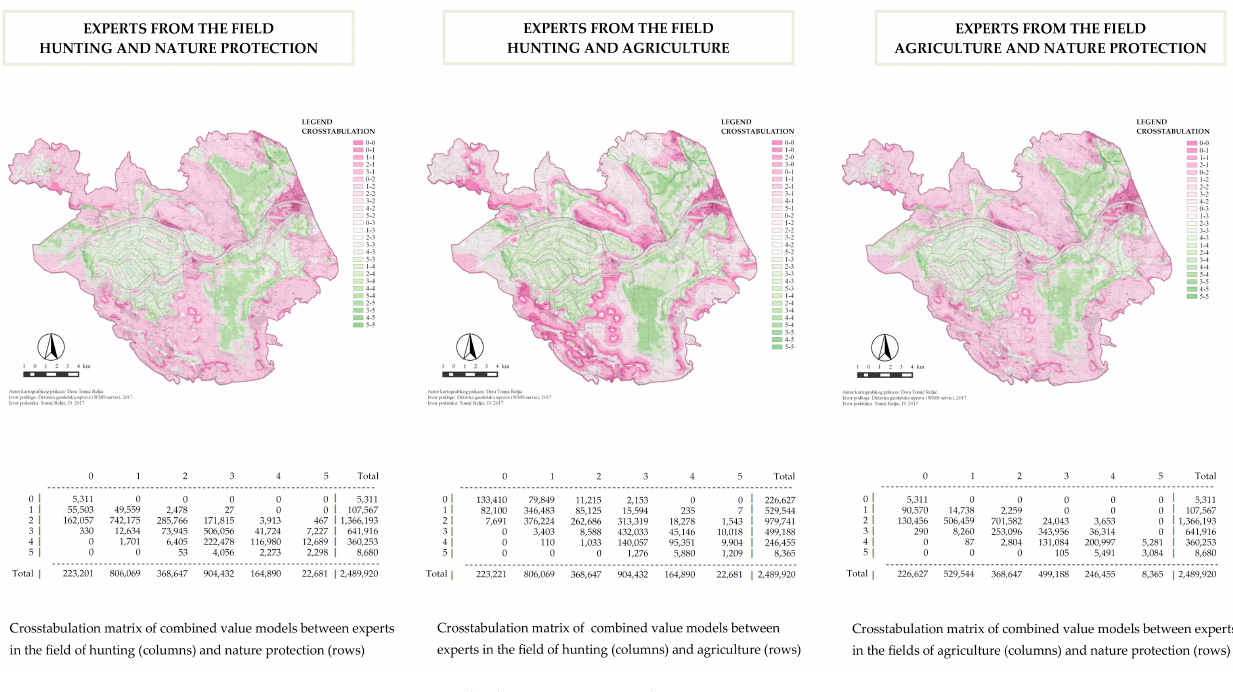
Figure 8. Cross-tabulation maps and matrices .